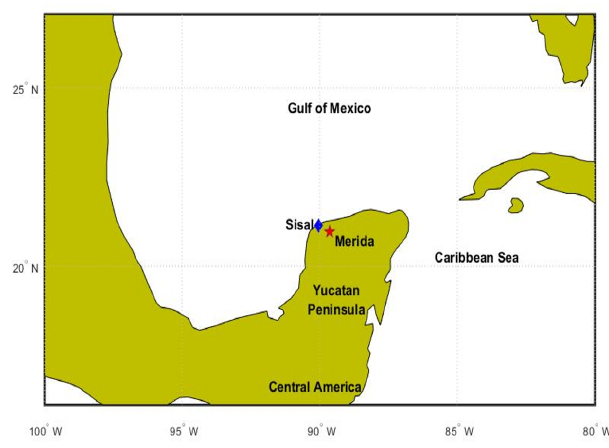
Figure 1. Map showing the Yucatán Peninsula and the sampling locations, i.e., Sisal (blue diamond) and Mérida (red star).